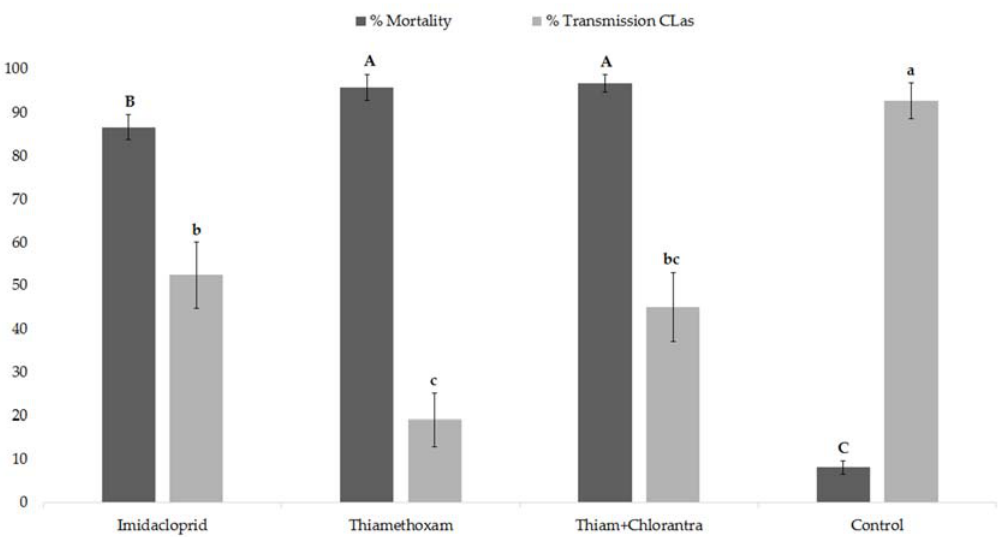
Figure 1. Percentage of mortality of Diaphorina citri and transmission rate of Candidatus Liberibacter asiaticus (12 months post-inoculation) on Citrus sinensis nursery tree treated by drench with systemic insecticides. Di ff erent upper case letters (% mortality) and lower case letters (% transmission C Las) represent significant di ff erences according to the Kruskal–Wallis test followed by a Student–Newman–Keuls test ( p < 0.05). Error bars represent standard error.